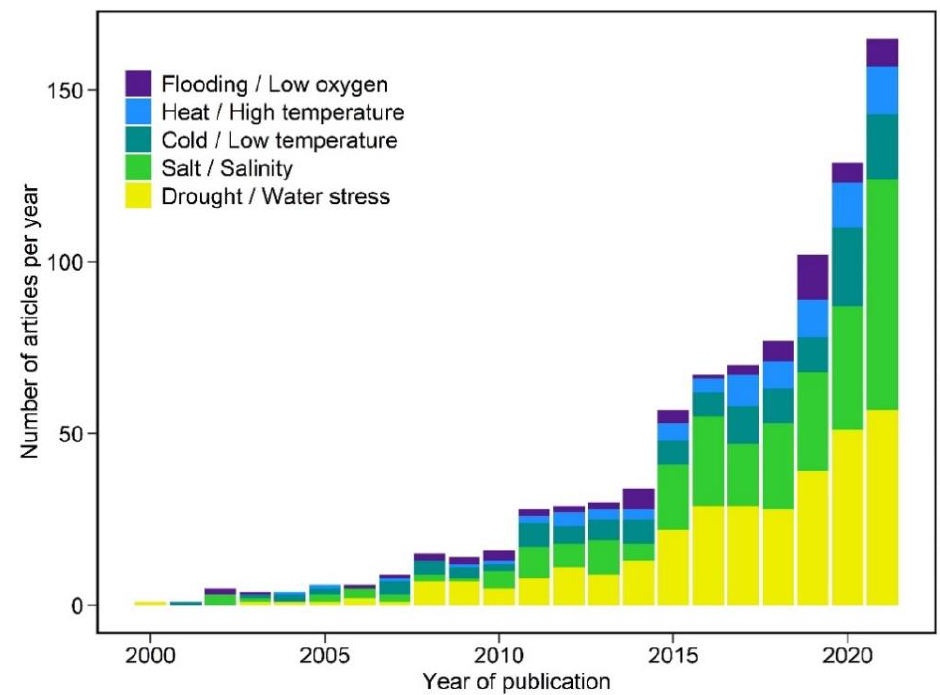
Figure 1. Number of publications per year from a Web of Science core collection search for research articles on metabolomics or metabolic profiling applied to plant response to major abiotic stresses from 2000 to 2021.